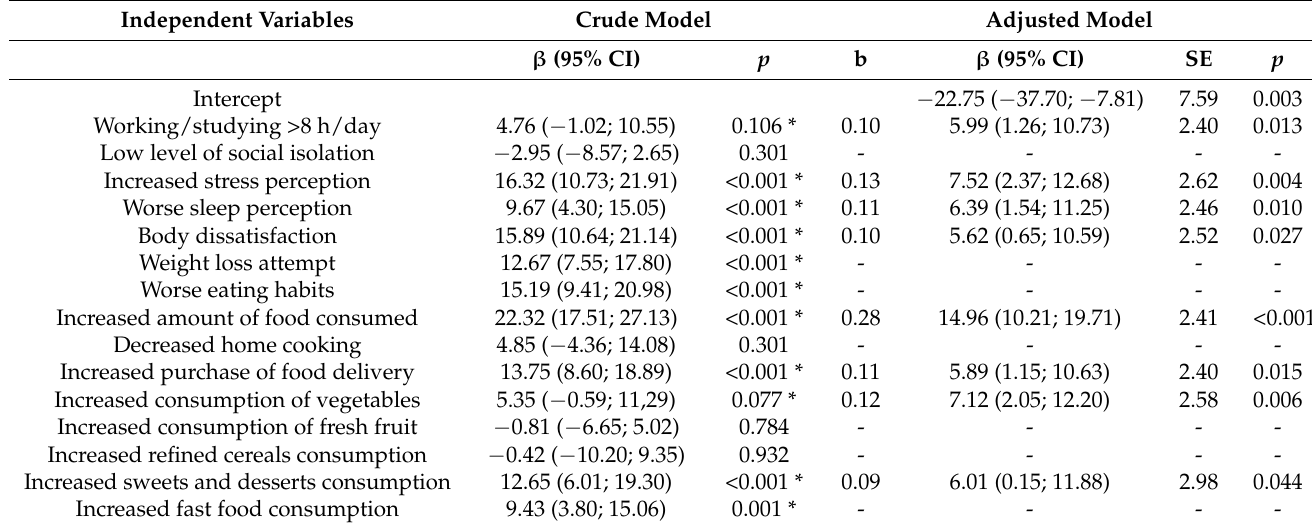
Table 4. Regression analysis of independent variables in relation to emotional eating of the inactive group ( n = 358). Independent